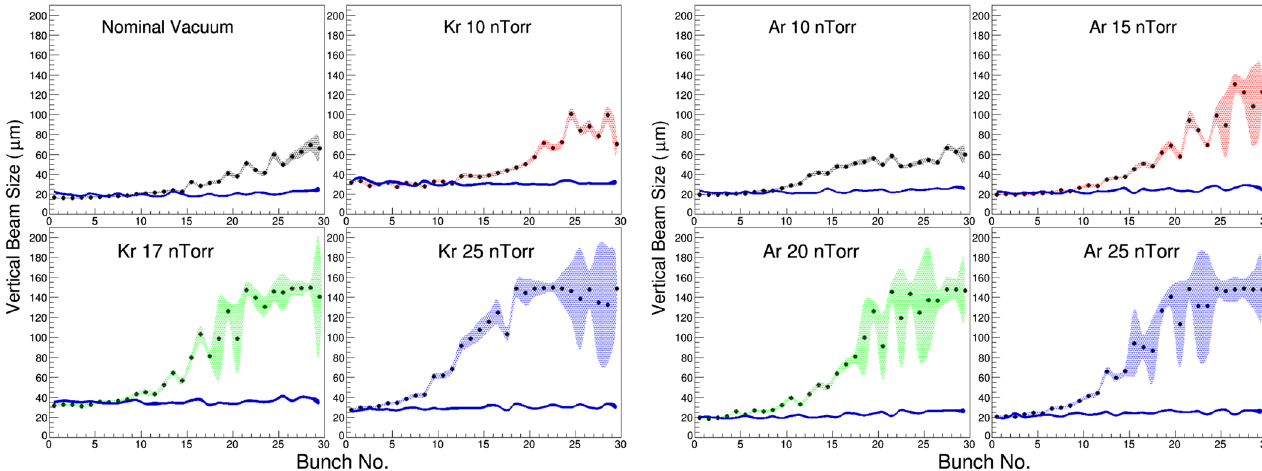
FIG. 4. Vertical bunch size as a function of bunch number at different pressures (lightly shaded ¼ RMS amplitude with vertical feedback off, filled ¼ feedback on, dots ¼ mean